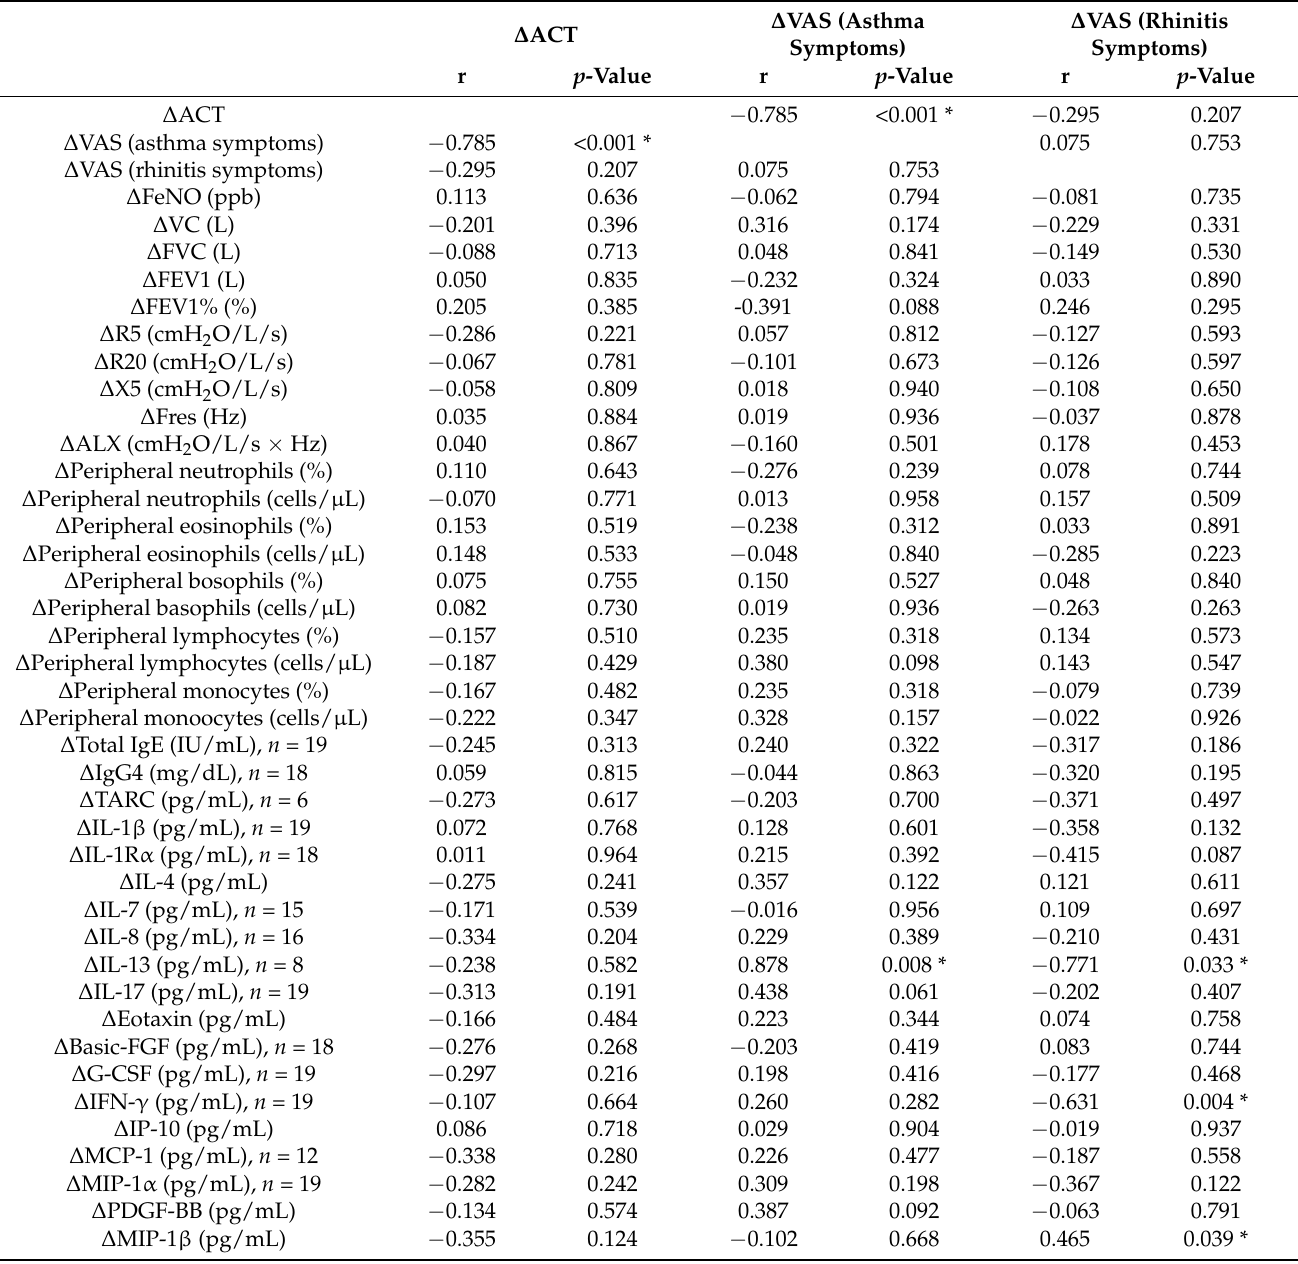
Table 3. Association between patient symptoms during the in-season and each parameter during the off-season. ∆ VAS ∆ ACT